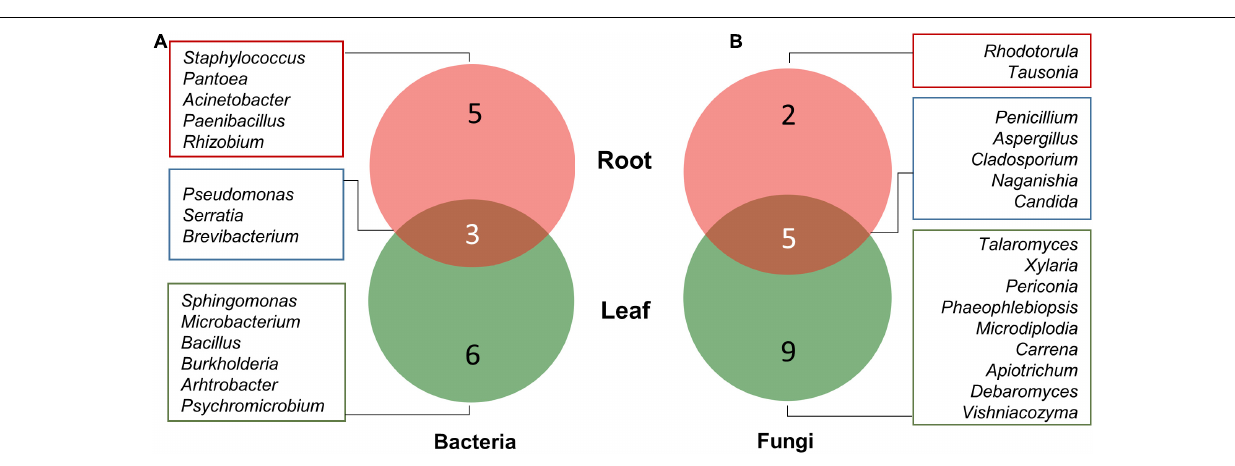
FIGURE 3 | Venn diagram illustrating the number of unique and overlapping bacterial (A) and fungal (B) endophytes isolated from leaf and root tissues of A. euchroma